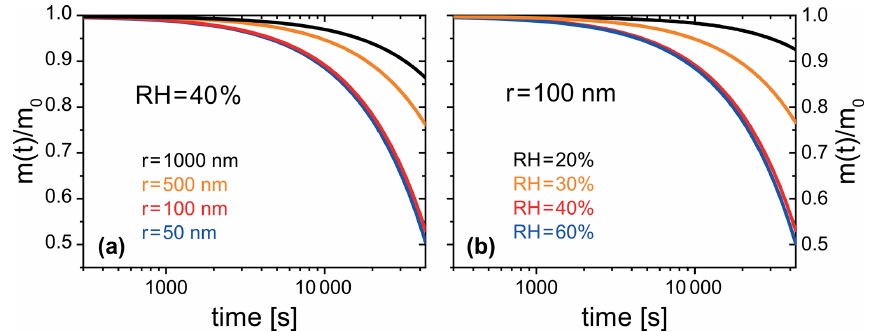
Figure 13. PRAD simulated organic mass loss of Fe III ( Cit )/ CA (molar ratio of 0.01) for (a) particles of different radii at 40% RH, and (b) particles with a radius of 100nm at different RH. All simulations were performed at 293.5K and for 12h solar irradiation at 30 ◦ zenith angle (Madronich et al.,